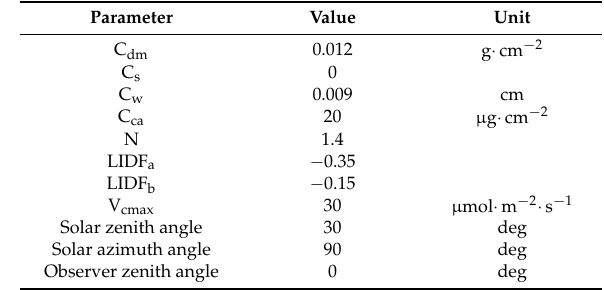
Table 4. The most relevant parameters used for the SCOPE simulations for a C3 canopy. Parameters C dm , C s , C w , C ca , and N are PROSPECT parameters [34], and refer to dry matter content, senescent material, water content, carotenoid concentration and leaf structure, respectively. LIDFa and LIDFb are leaf angle distribution parameters [36]. The values in the table refer to a spherical distribution of leaves. V cmax is the maximum carboxylation rate. The solar zenith and azimuth angles and observer zenith angle are also